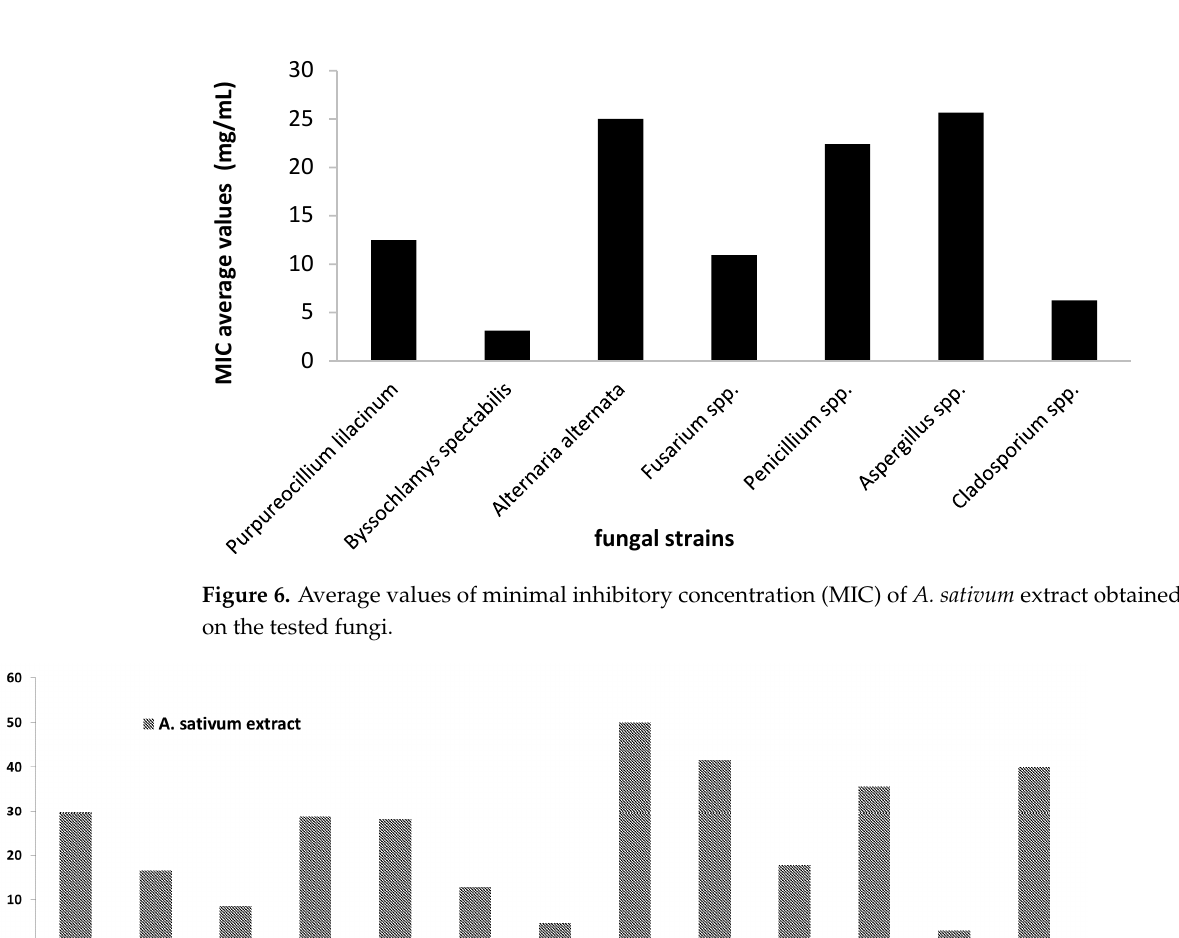
Figure 7. Average values of minimal inhibitory concentration (MIC) of A. sativum extract on strains belonging to Penicillium and Aspergillus genera.